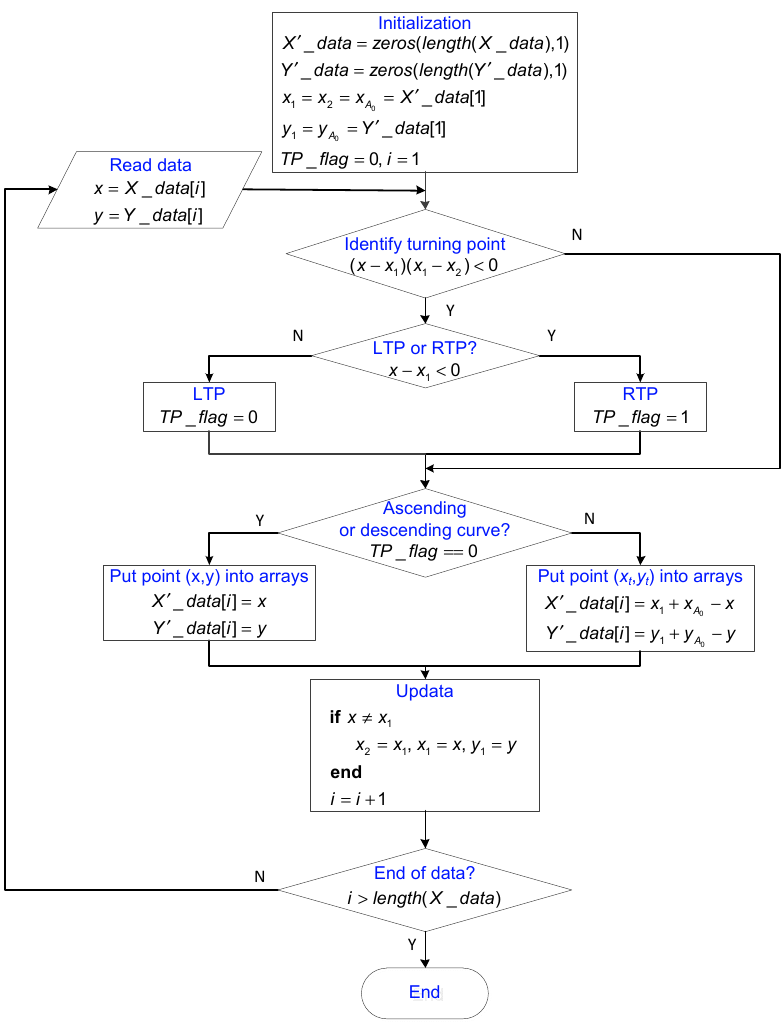
( ) f x to corresponding points on 1